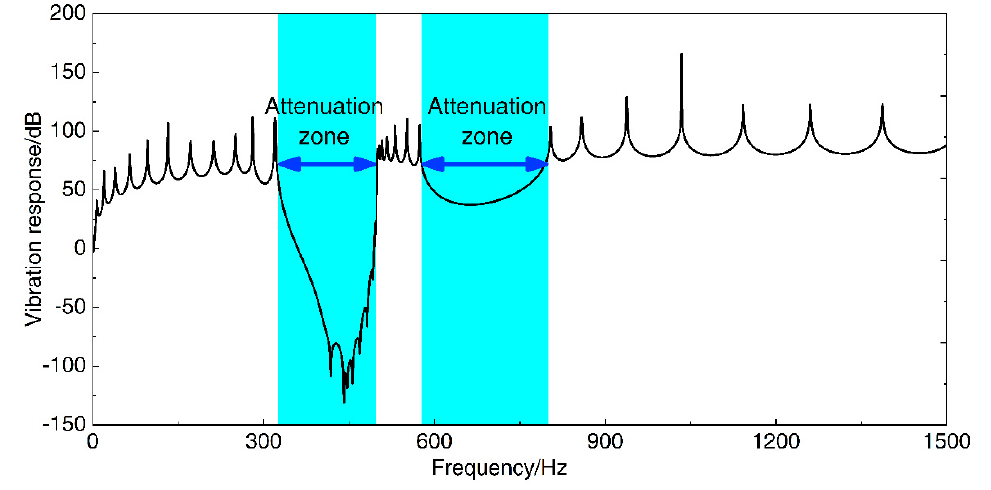
Figure 4. Band gaps and vibration attenuation properties represented by flexural wave vibration frequency response function.